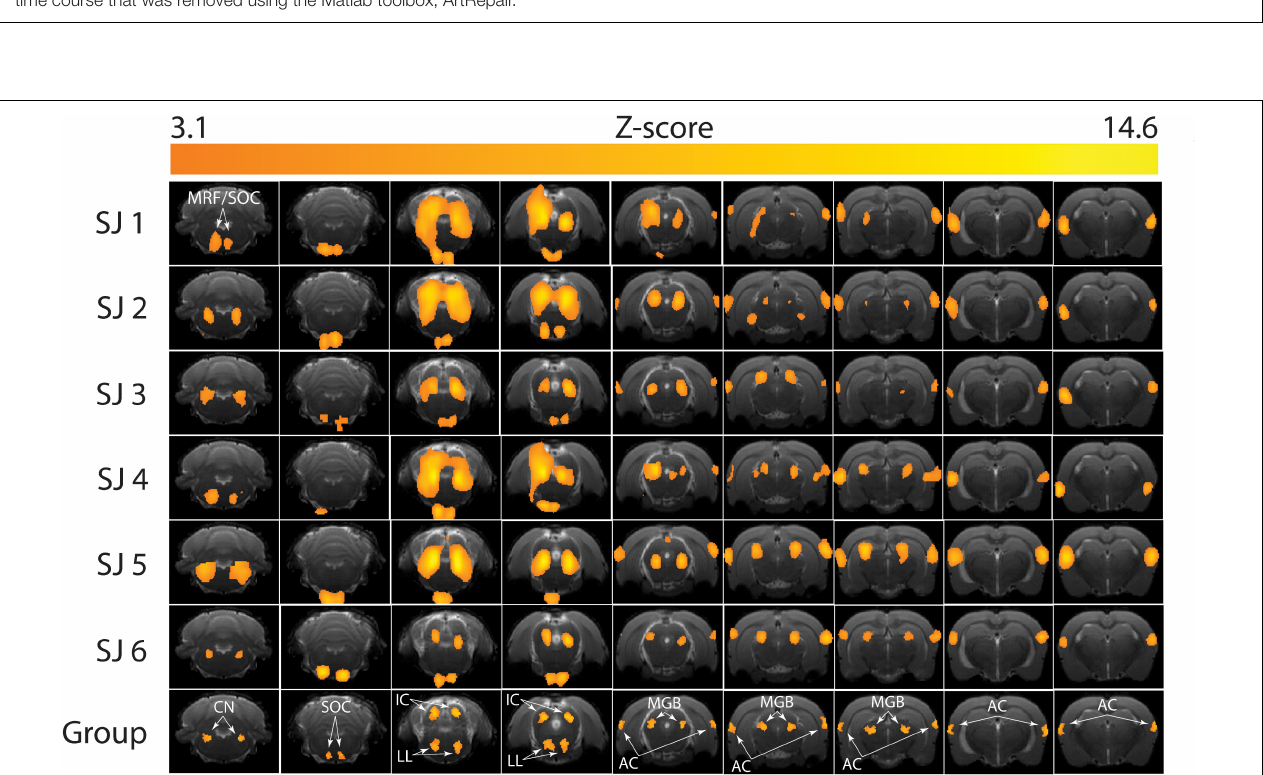
FIGURE 7 | Brain activation patterns during the functional magnetic resonance imaging (fMRI) auditory task. The Z -score maps are reported for each subject (SJ 1-6) at the end of the first-level analysis, and for the whole group after the higher-level analysis (bottom row). MRF, medullary reticular formation; CN, cochlear nucleus; SOC, superior olivary complex; IC, inferior colliculus; LL, lateral lemniscus; MGB, medial geniculate body; AC, auditory cortex. Higher single-subject-consistency is present in the IC, LL, MGB, and AC and lower single-subject-consistency in the CN and SOC.